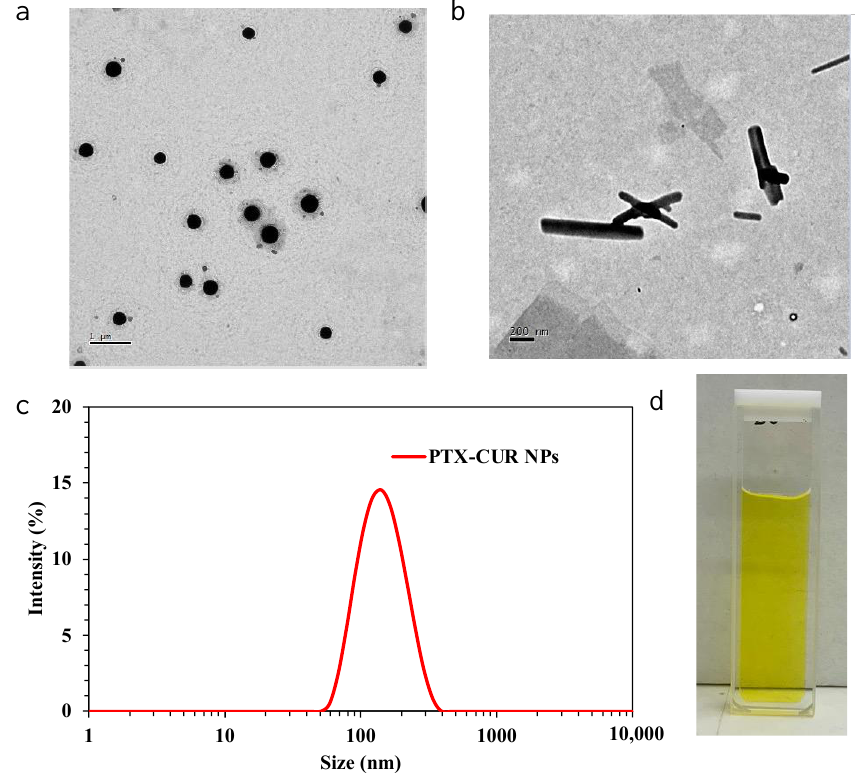
Figure 2. ( a ) TEM image of 1:1 PTX-CUR ( w / w ) NPs with 65% CUR — the scale bar is 1 µm; ( b ) TEM image of PTX NPs showing the formation of needle-like aggregates — the scale bar is 200 nm; ( c ) representative DLS size distribution result of 1:1 ( w / w ) PTX-CUR NPs with 65%; ( d ) digital image of 1:1 PTX-CUR ( w / w ) NP solution in a quartz cuvette. PTX and CUR stand for paclitaxel and curcumin.